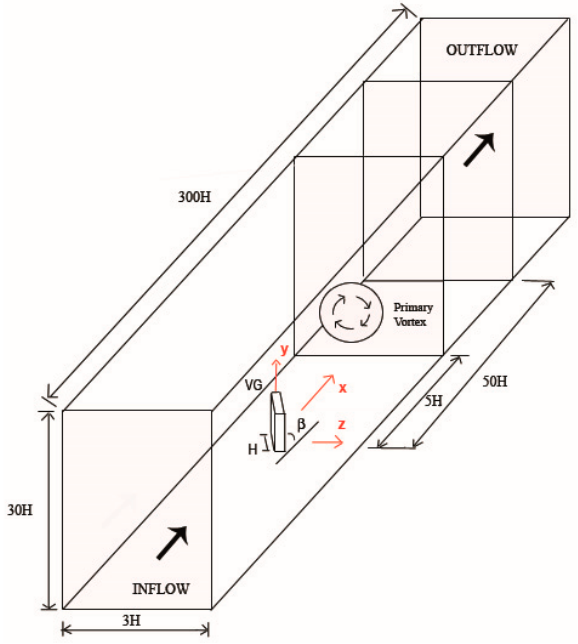
Figure 3. Sketch of the computational domain. Dimensions are scaled by the baseline VG height H (not to scale).